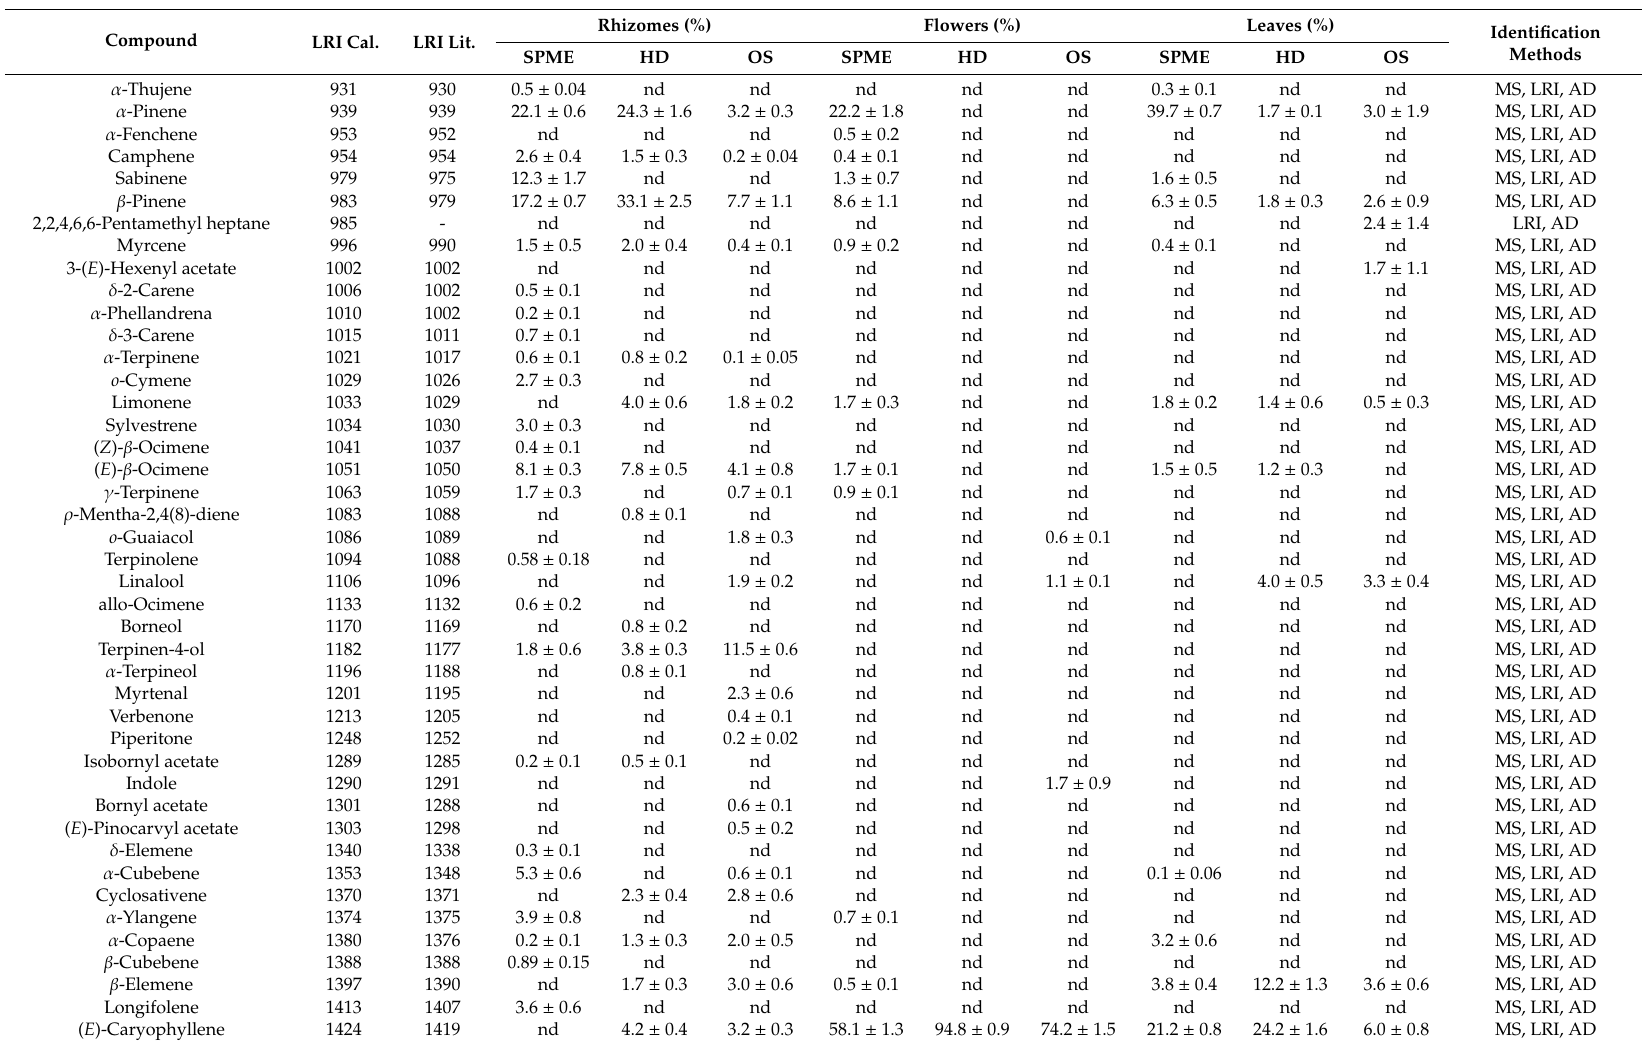
Table 1. Chemical compositions of fresh rhizomes, flowers, and leaves of Zingiber